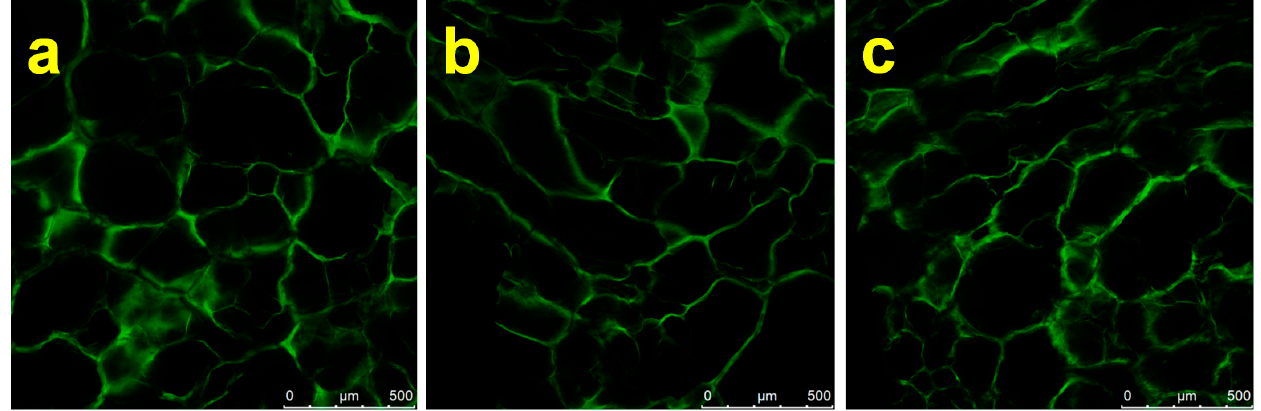
Figure 3. CLSM micrographs of the macroporous cryogels DDA-Gel: ( a ) 1:1, ( b ) 1:2, and ( c ) 1:3.